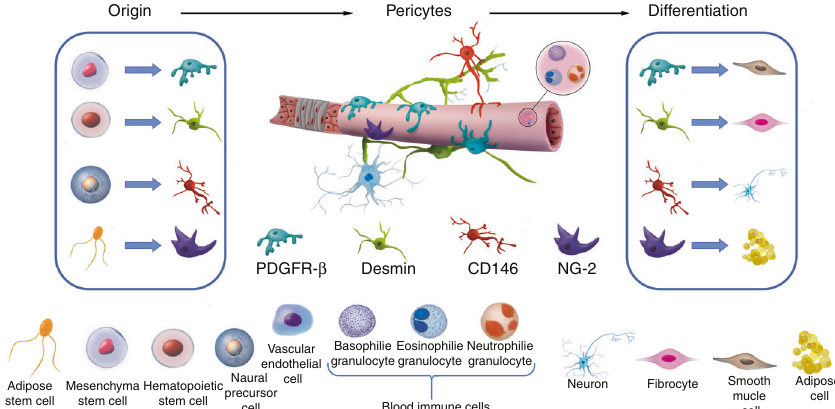
Fig. 2 Schematic model showing pericytes by the expression of pericyte markers of PDGFR β , CD146, desmin, and NG2 as examples, and their potential differentiation lineages